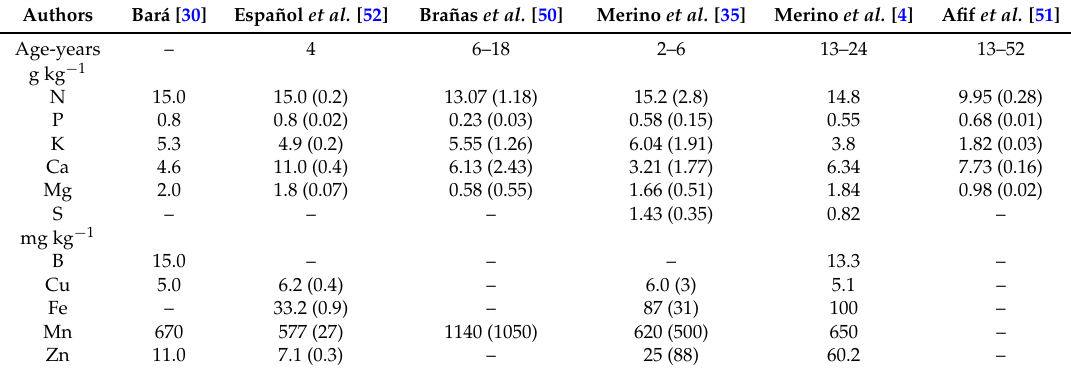
Table 2. Average nutrient concentrations in Eucalyptus globulus leaves in Northwest Spain. The standard deviations are show within brackets for [35], [50] and [51]. Standard errors are shown within brackets for [52].